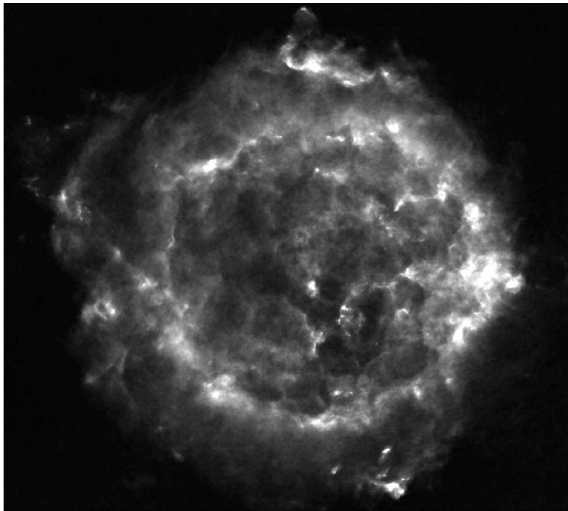
Fig. 1. An example of processing the raw observation data. To obtain this 5 GHz radio brightness map of the Cas A (ObsID AR0435), the raw archival data from different configurations of the Very Large Array (VLA) radio telescopes had to be combined and correlated, bad data detected and removed, then a source model had to be created using the CLEAN algorithm. This requires detailed understanding of the telescope operation and the data processing.